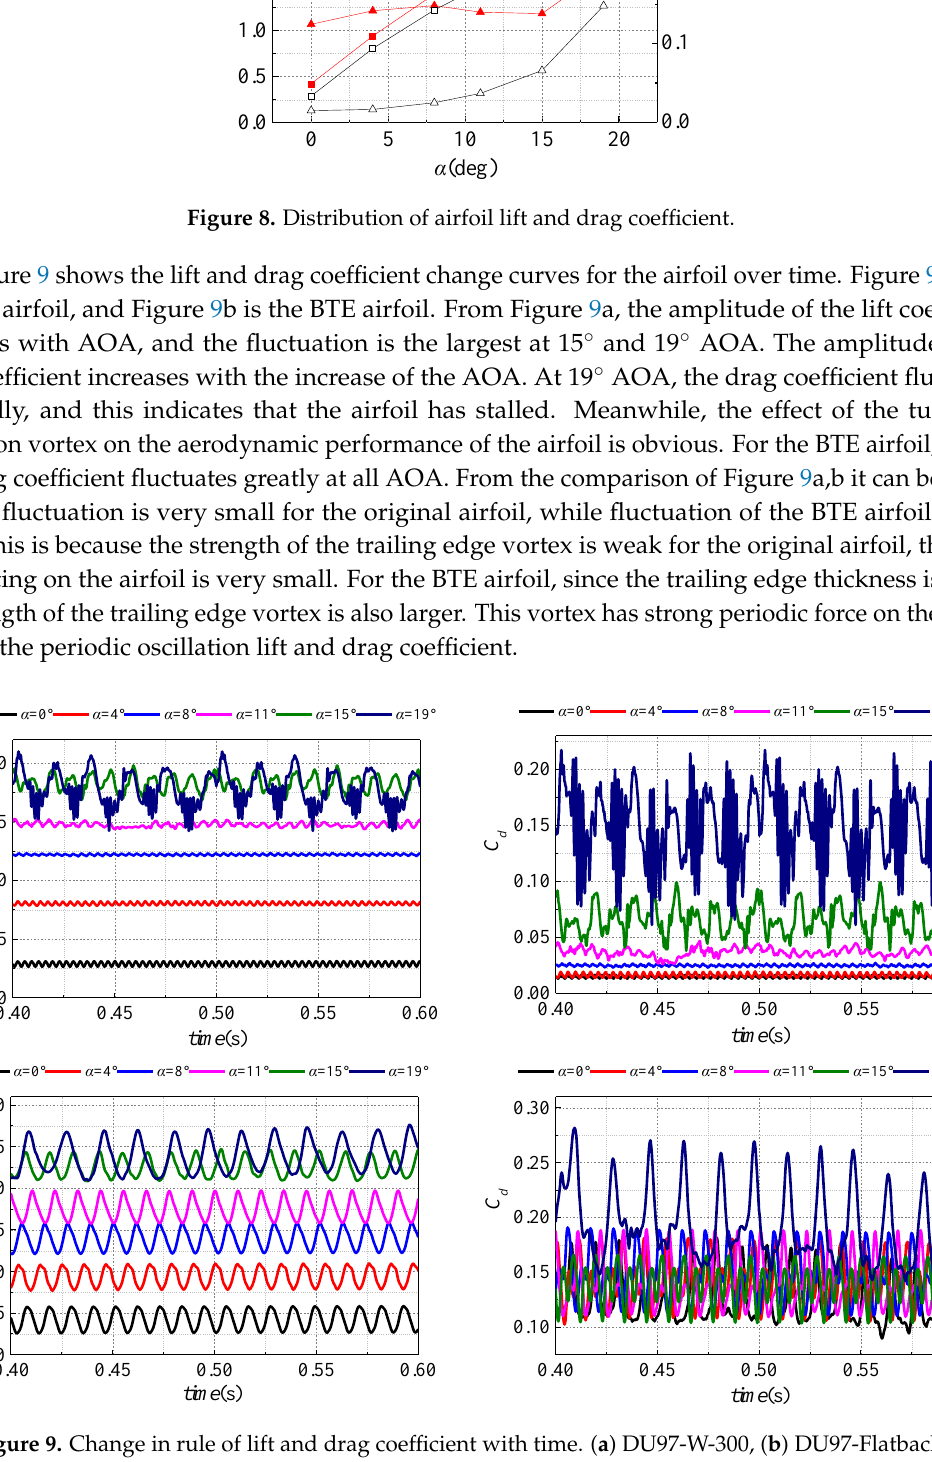
Figure 9. Change in rule of lift and drag coefficient with time. ( a ) DU97-W-300, ( b ) DU97-Flatback.